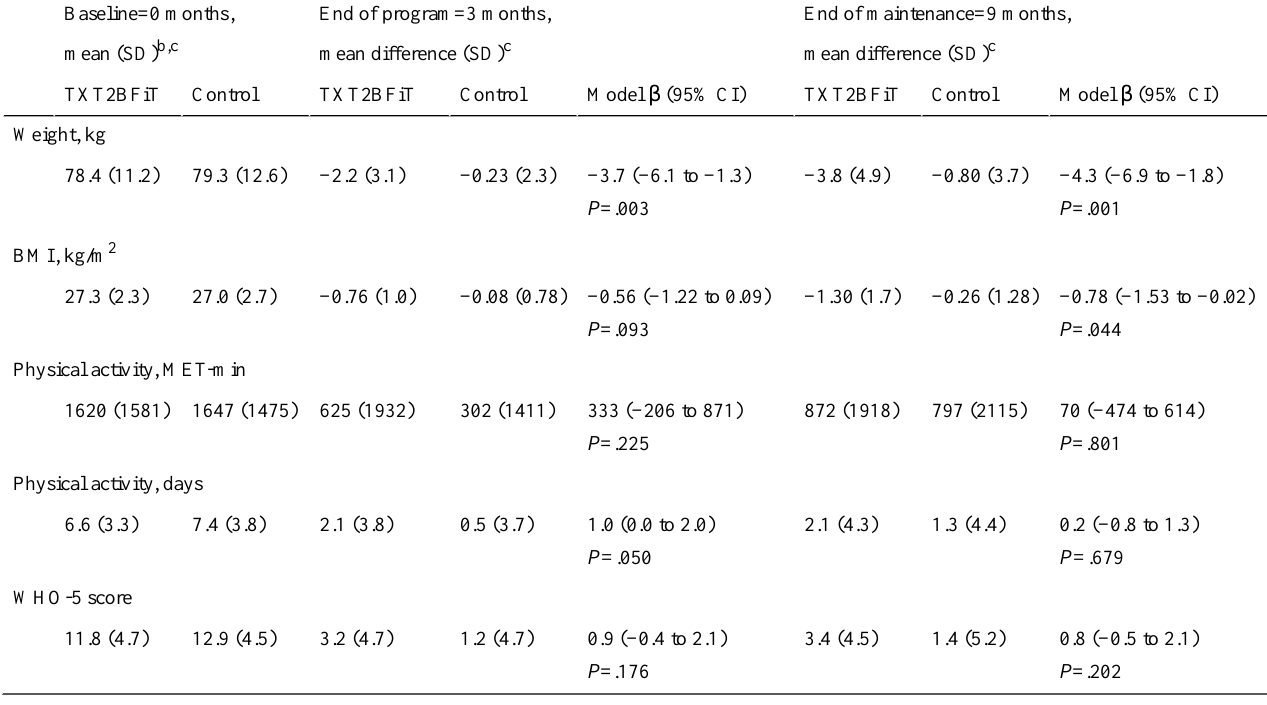
Table 2. Comparison of self-reported weight, BMI a , and physical activity in intervention (n=123) versus control (n=125) at baseline, end of program (3 months), and end of maintenance periods (9 months).